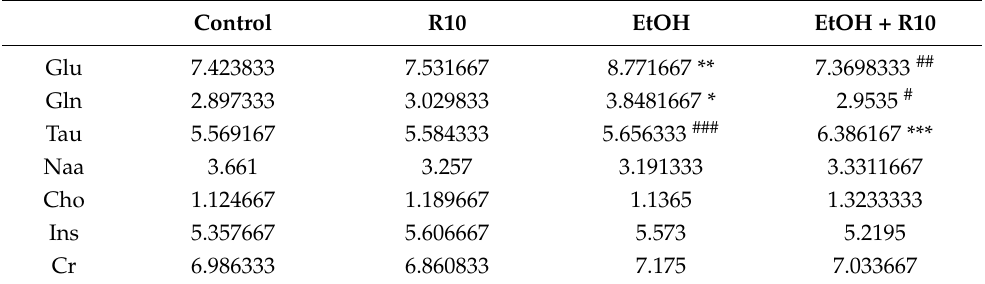
Table 1. Glu, Gln, Tau, Naa, Ins, Cho, Cr concentrations in the hippocampal DG in adult male rats. Results are expressed as mean ± S.E.M. of 6 subjects per